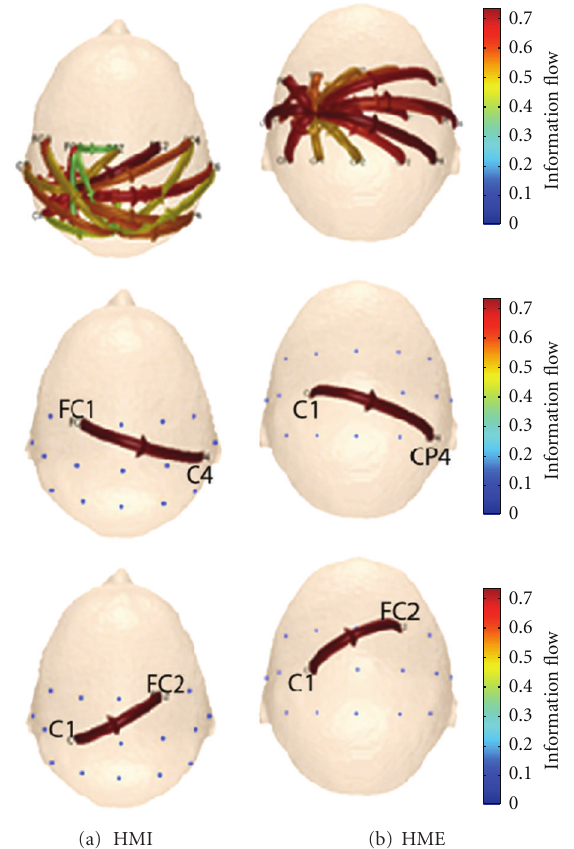
Figure 5: Functional connectivity patterns at the electrode plane for one representative subject during (a) Hand Motor Imagery (HMI) and (b) Hand Motor Execution (HME). First row: information exchange between all channels. Second and third rows: maximal information